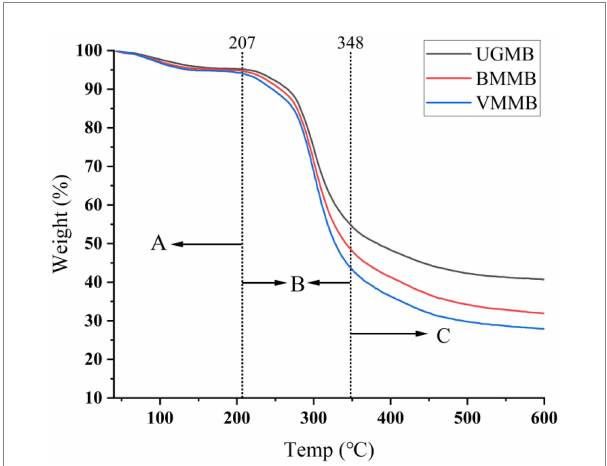
FIGURE 5 Thermal curve of mung bean flour: (A) is the water evaporation stage, (B) is the rapid pyrolysis stage, (C) is the carbonization stage.